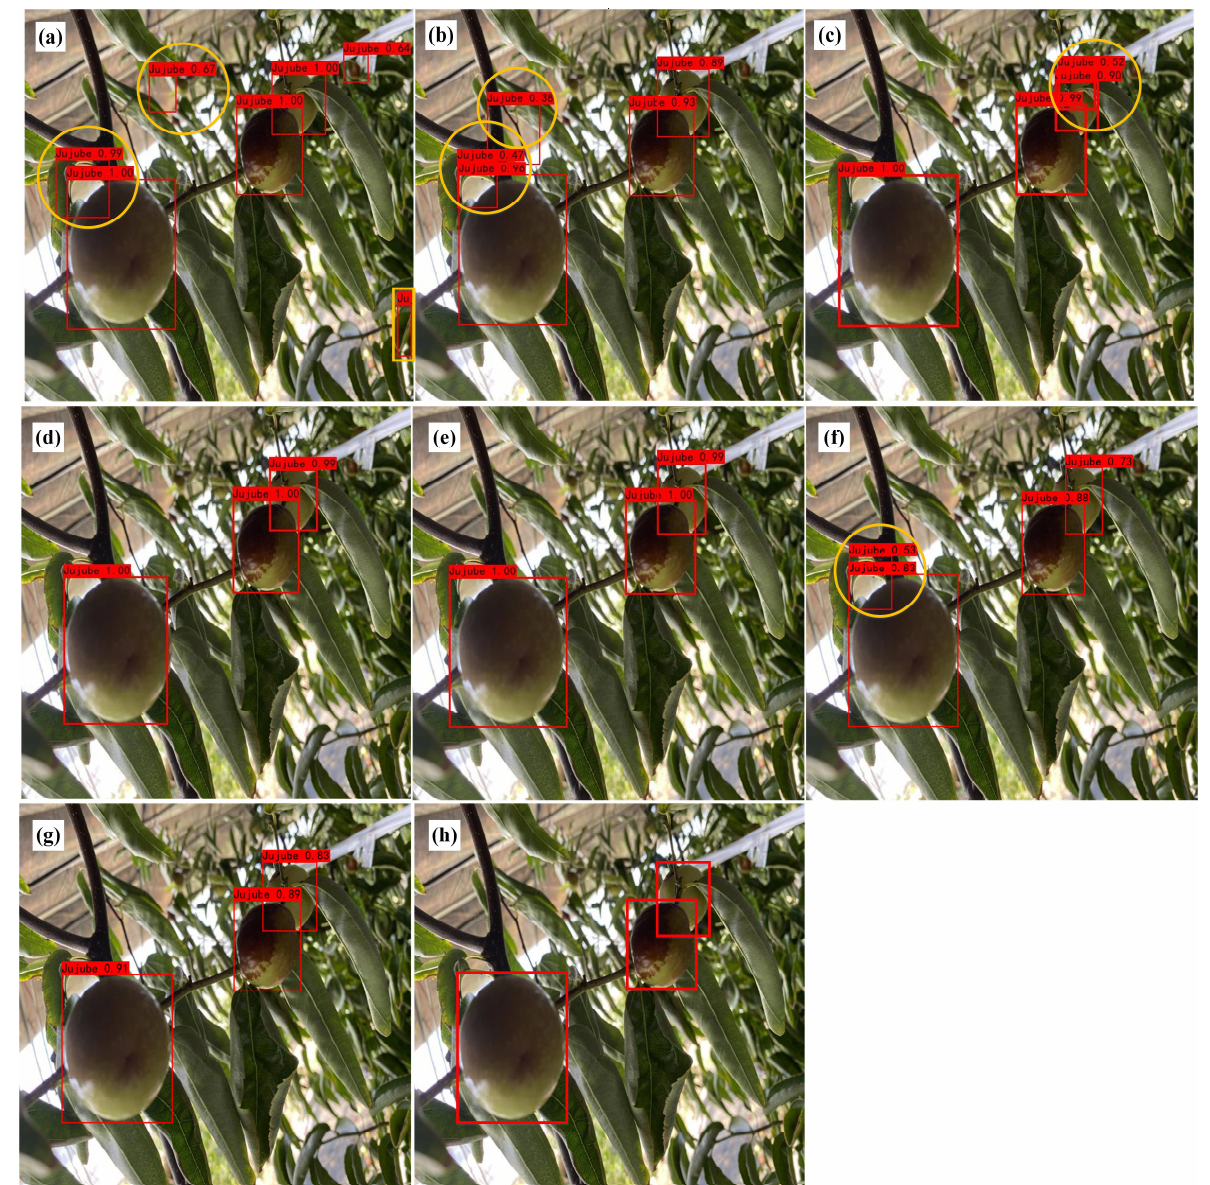
Figure 9. Recognition results with different models on a backlit scene. ( a ) Faster R-CNN, ( b ) Efficientdet, ( c ) SSD, ( d ) YOLOv3, ( e ) YOLOv4, ( f ) YOLOv5-S, ( g ) Ours, ( h ) Ground Truth.